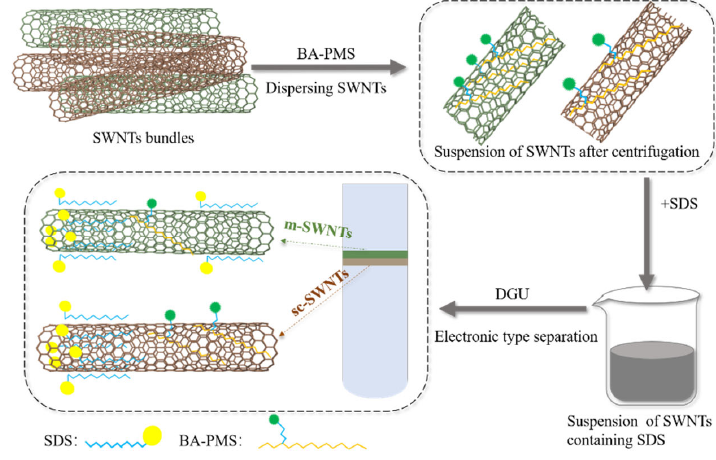
Figure S3. Raman spectra of (a) as–prepared SWNTs, (b) heat–treated SWNTs, and (c) primarily purified SWNTs, respectively; Figure S4. Nis–VIR spectra of (a) as–prepared SWNTs, (b) heat–treated SWNTs, and (c) primarily purified SWNTs, respectively; Figure S5. The UV–Vis–NIR spectrum of water–soluble BA–PMS; Figure S6. photographs of (a) SWNTs dispersed BA–PMS, (b) the aqueous solution of DOC, and (c) SWNTs dispersed in water. (d–f) are taken after (a–c) setting for 90 days, respectively; Figure S7. Lorentz–fitted curves of G–bands of primarily purified SWNTs (black lines) and BA–PMS–dispersed SWNTs (red lines) at (a–b) 458 and (c–d) 633 nm excitation wavelengths, respectively; Figure S8. Purity calculation of Vis–NIR absorption spectra of (a) top green layer, (b) bottom red–brown layer, and (c) original SWNTs; Figure S9. The absorption spectra of (a) SWNTs dispersion before DGU separation, DGU separated (b) m–SWNTs, and (c) sc–SWNTs dispersions; Figure S10. Raman spectra of the SWNTs in the top green layer and the bottom red–brown layer at the excitation of (a) 514 and (b) 532 nm, respectively, in the ranges of 100–1700 cm − 1 ; Figure S11. Lorentz–fitted curves of G–bands of the bottom red–brown layer (brown lines) and top green layer (green lines) at (a–b) 458, (c–d) 514, (e–f) 532, and (h–g) 633 nm excitation wavelengths, respectively; Figure S12. Raman spectra of the BA–PMS–dispersed–SWNTs at the excitations of (a) 514 and (b) 532 nm, respectively, in the range of 100–300 cm − 1 ; Figure S13. Gaussian fit curves of Vis–NIR absorption spectra of BA–PMS–dispersed SWNTs; Figure S14. Gaussian fitting curves for the